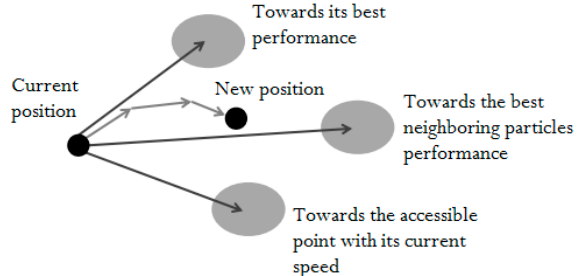
Figure 5. Displacement of a particle in the PSO algorithm.